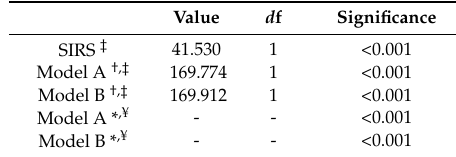
Table 6. Goodness-of-fit test results using Pearson Chi-Square Test and Fisher’s Exact Test. Value d f